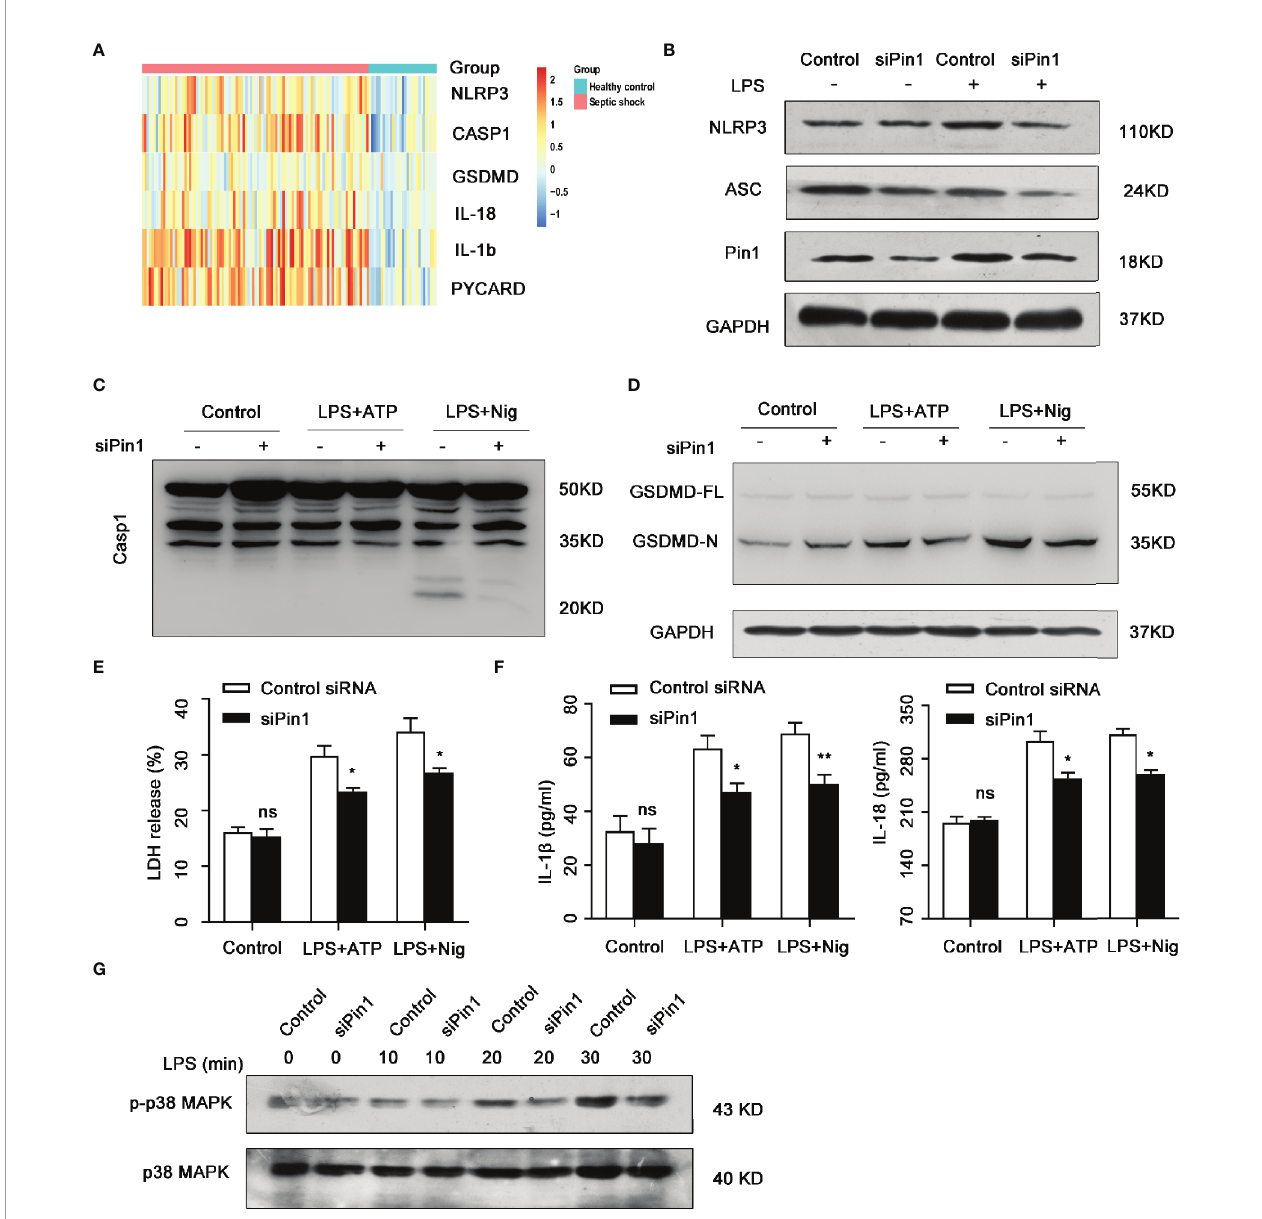
FIGURE 6 | Pin1 knockdowndown-regulated NLRP3 in fl ammasome in human septicshock. (A) Analysis of in fl ammatorygenes in published clinicaldatasets GSE26440. (B) PMA-differentiated THP-1 cells were transfected with control siRNA or siPin1 followedby stimulation with 500 ng/ml lipopolysaccharide(LPS) for 4 h. Cellextracts were immunoblottedfor NLRP3 in fl ammasomes. (C) PMA-differentiated THP-1 cells were transfected with controlsiRNA or siPin1 followedby stimulation with 500 ng/ml LPS for 4 h and treatment with 5 mMATP or 20 mM nigericin for 30 min.Immunoblot was performed for caspase-1 activation.in cellextracts. (D) PMA-differentiated THP-1 cells were transfected with control siRNA or siPin1 followedby stimulation with 500 ng/ml LPS for 4 h and treatment with 5 mMATP or20 mM nigericin for 30 min. Immunoblot was performed for GSDMD cleavage incellextracts. (E,F) PMA-differentiated THP-1 cells were transfected with control siRNA orsiPin1 followed bystimulation with 500 ng/ml LPS for 4 h and treatment with 5 mMATP or 20 mMnigericin for 30 min.Supernatants were analyzed for LDH, IL-1 b , and IL-18. (G) Immunoblot analysisfor activation of p38 MAPK inPMA-differentiated THP-1 cells transfected with control siRNA orsiPin1 and stimulated with LPS (500 ng/ml) for 0, 10, 20, and30 min. The data represent the mean ± SD of one among three biologicalreplicates, with three technicalreplicates each. *P < 0.05; **P < 0.01; ns, nosigni fi cance; two-way ANOVA (E, F)